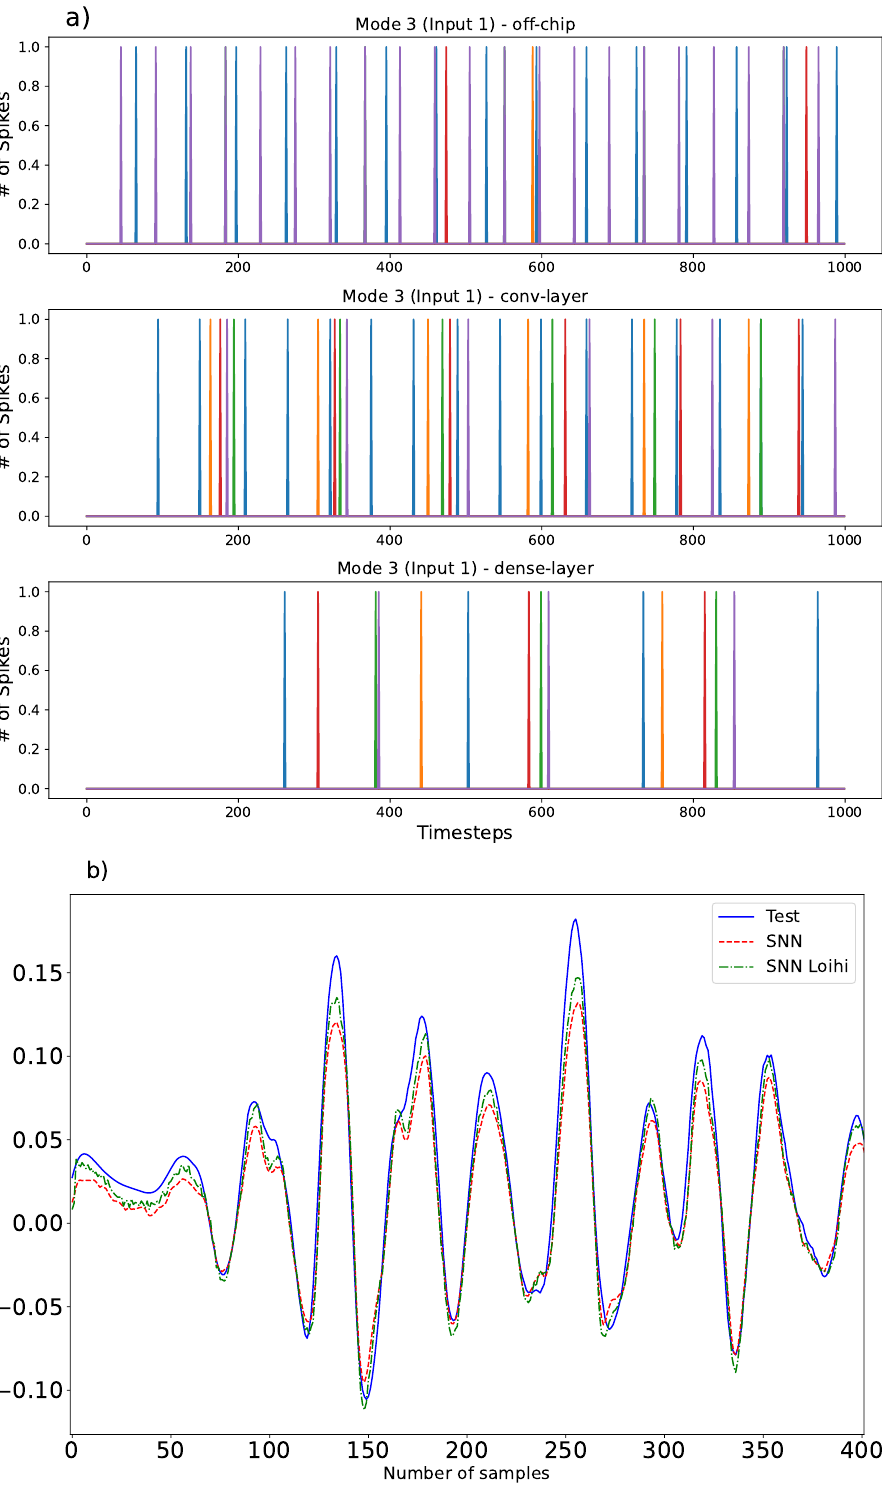
Figure 9. Results for mode 3: ( a ) Neural activities of 5 neurons of each layer. One input vector is shown over 1000 timesteps. ( b ) Predictions over the testing set with the SNN architecture (dashed red line) and running the SNN on the Loihi emulator (dash-dot green